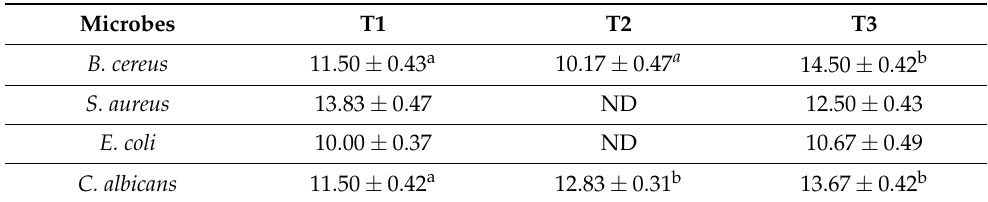
Table 1. Zone of inhibition (mm) of turmeric, aloe vera and a combination of both extract against food borne